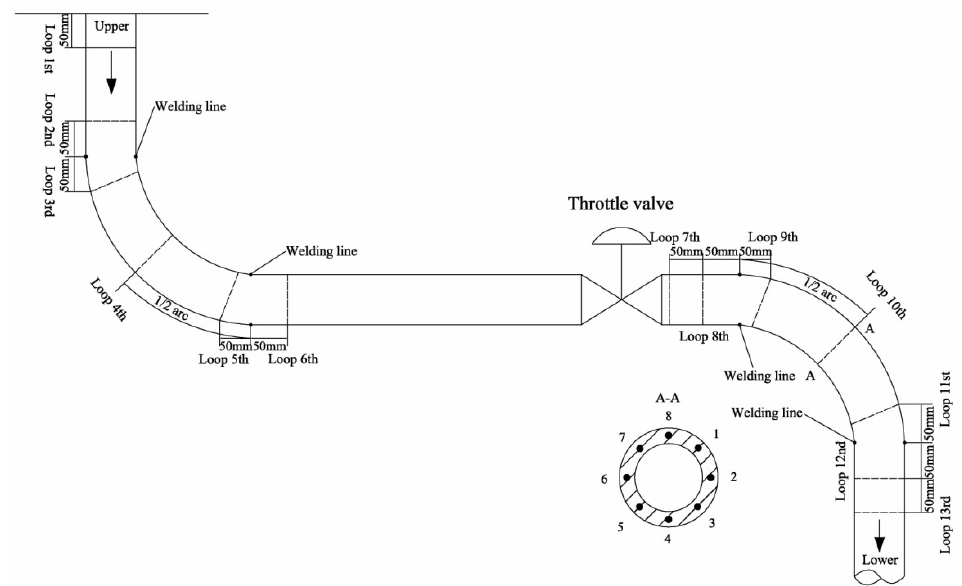
Figure 5. Schematic diagram of position distribution for detection points.